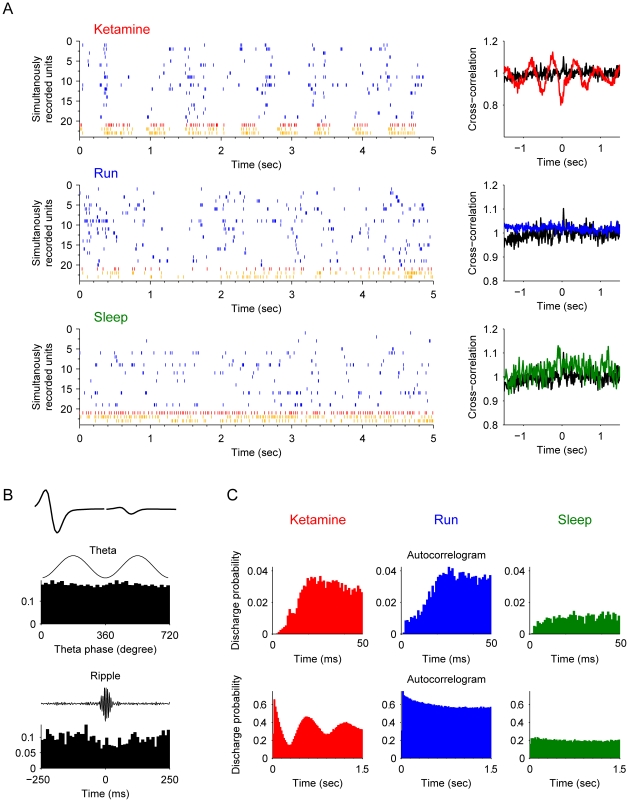
Properties of type-5 interneurons.(A) Spike rasters of silmultanously recorded pyramidal cells (blue) and type-5 interneuron (an example unit plotted is in red, and other type-5 interneurons in orange) after ketamine injection, during running and slow-wave sleep are shown (left subpanels). The cross-correlation functions of the interneuron and pyramidal cell joint-activities are plotted on the right. The black line is the cross-correlation during the awake rest state. (B) The basic properties of this type-5 unit. The most upper left panel shows the average spike waveforms. Firing probability histograms suggest that the neuronal firing timing showed slight correlation with theta oscillations but was not coupled to ripple oscillations (middle left and lower left panels). (C) Autocorrelograms in different states: after ketamine injection, during running, and during sleep respectively. Autocorrelograms are shown in two time scales: 0–50 ms and 0–1.5 sec. Note the slow oscillatory dynamics-induced by ketamine is evident in both cross-correlation plot (the top right corner plot in A) and the longer time scale autocorrelogram (bottom left corner plot in C).